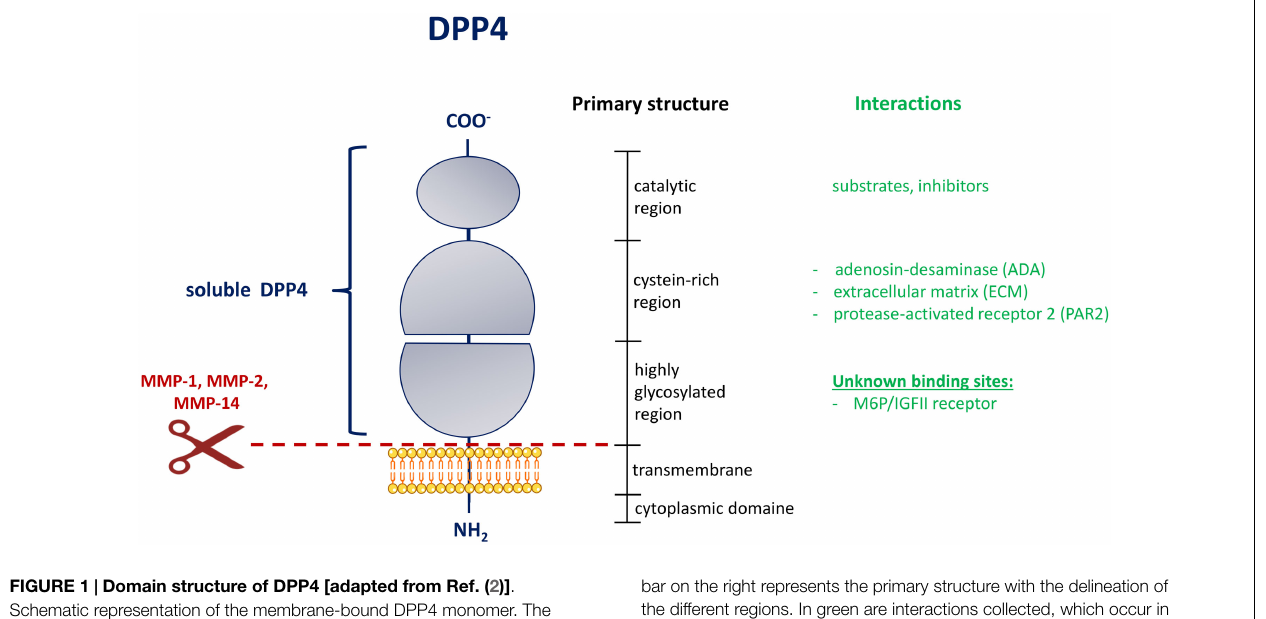
FIGURE 1 | Domain structure of DPP4 [adapted from Ref. (2)] . Schematic representation of the membrane-bound DPP4 monomer. The extent of the circulating and soluble form of DPP4 is illustrated on the left in blue. The shedding of DPP4 from the membrane by indicated matrix metalloproteinases is shown by a scissor symbol in red. The vertical black